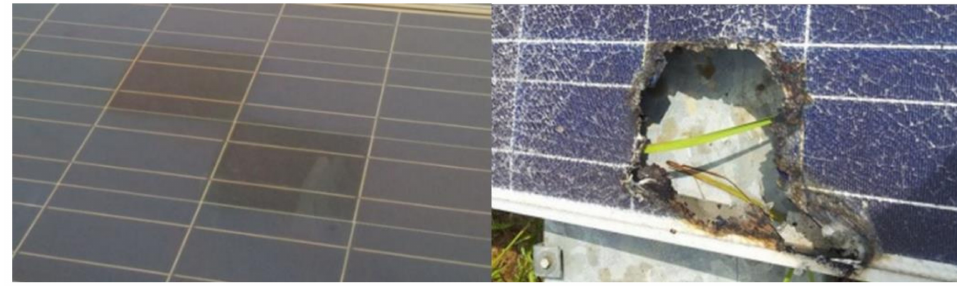
Figure 4. PV module with hot